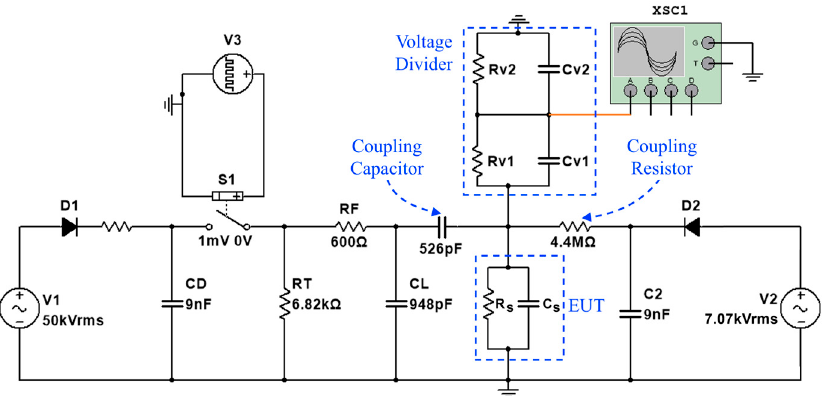
Figure 3. The established LI and DC composite voltage experiment circuit on the simulation.